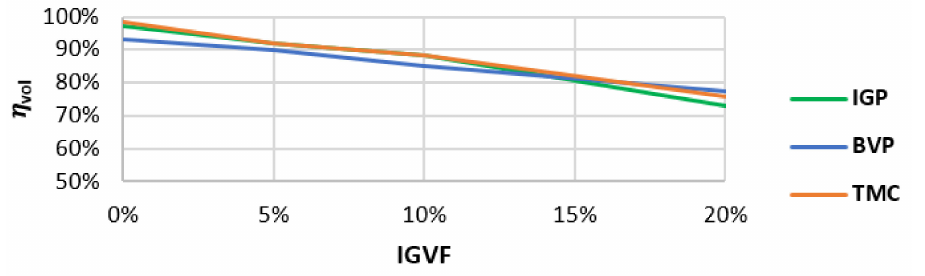
Figure 24. Volumetric efficiencies obtained from the CFD simulations at p 2 = 5 bar pressure load, 20 ◦ C oil temperature and 2000 rpm while increasing the